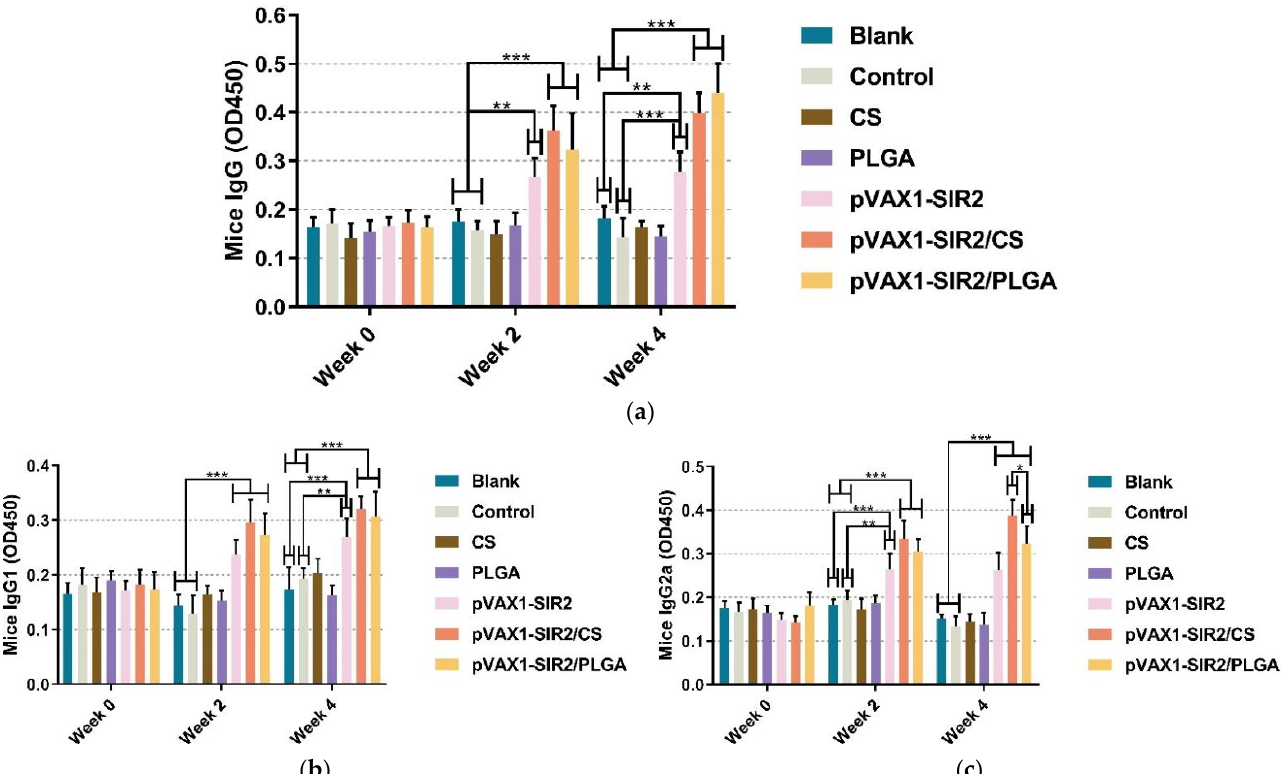
Figure 5. Secretions of IgG ( a ), isotypes IgG1 ( b ), and IgG2a ( c ) in the sera separated from immunized animals at week zero, two, and four. The dilution ratio of tested sera was 1:100 in ELISA analysis, and each serum was investigated once. Values were analyzed by one-way ANOVA analysis followed by Dunnett ’ s test. Values between the pVAX1-SIR2/CS and pVAX1-SIR2/PLGA group were estimated by the independent t -test. Values were shown as mean of OD450 ± SD ( n = 5). * p < 0.05, ** p < 0.01, and *** p < 0.001 compared with blank or control